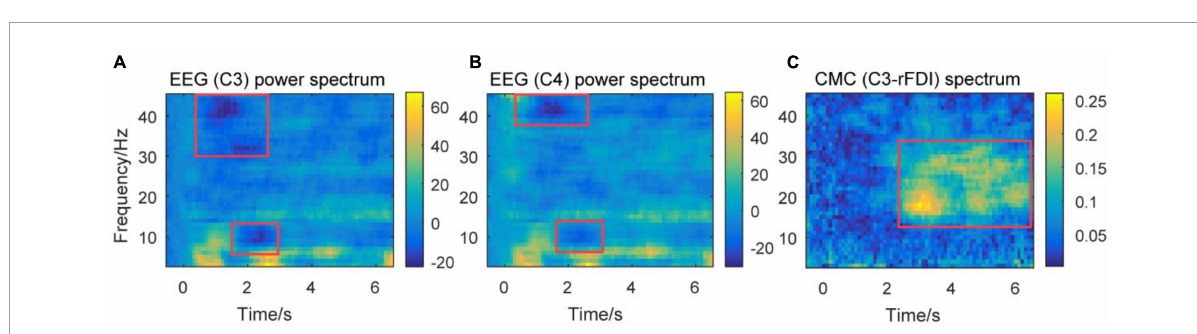
FIGURE5 Time-frequency plots of percent change of power spectra of EEG signals, and CMC spectrum from a representative participant. Time frequency plots of percent change of EEG power spectrum over channels C3 (A) and C4 (B) from a representative participant. Time frequency plots of CMC spectrum between channel C3 and EMG in rFDI muscle (C) from a representative participant. The horizontal axis means the time, the vertical axis means frequency. EEG, Electroencephalogram; EMG, electromyography; rFDI, right first dorsal interosseous; CMC, corticomuscular